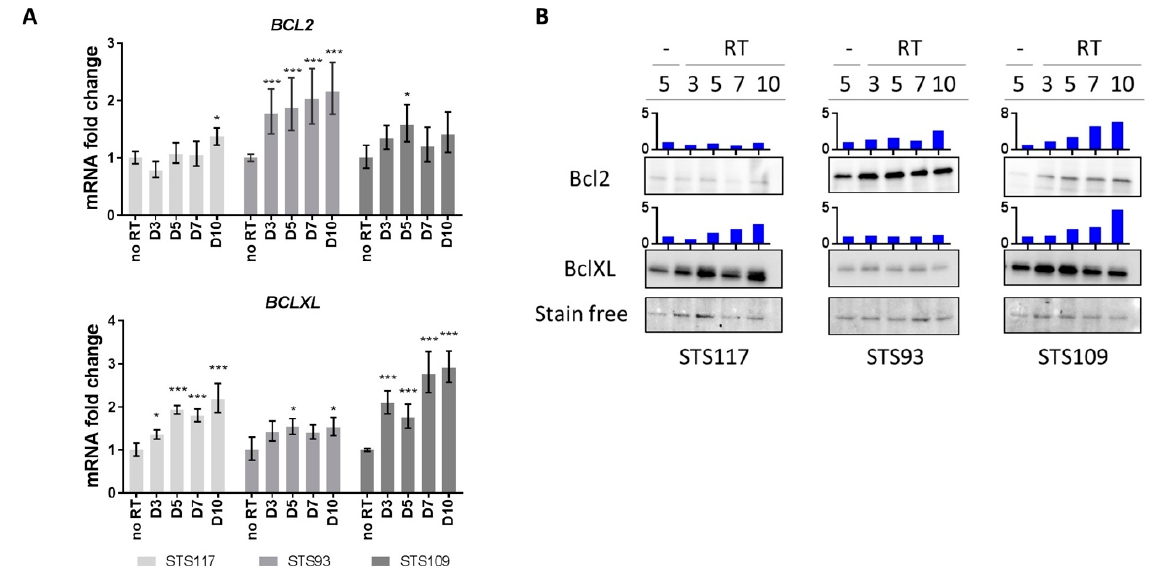
Figure 3. Anti-apoptotic proteins of the Bcl-2 family are upregulated by radiation. ( A ) Relative mRNA levels of BCL-2 and BCL-XL over time evaluated by real-time qPCR following 8 Gy of radiation. The values represent fold change expression relative to untreated controls. ( B ) Western blot analysis of BCL-2 and BCL-XL protein levels of untreated control (-) at Day 5 and irradiated (RT) cells over time. Stain free is a representative band of total protein acquired by stain-free technology. Bar graph (in blue) represent the protein quantification relative to the total protein. Data in ( A ) were analyzed using two-tail Student’s t-test to compare untreated vs. RT treated cells. * p < 0.05, *** p < 0.001. Data representative of three experiments for qPCR and one experiment for western blot. Error bars indicate ± the standard deviation.